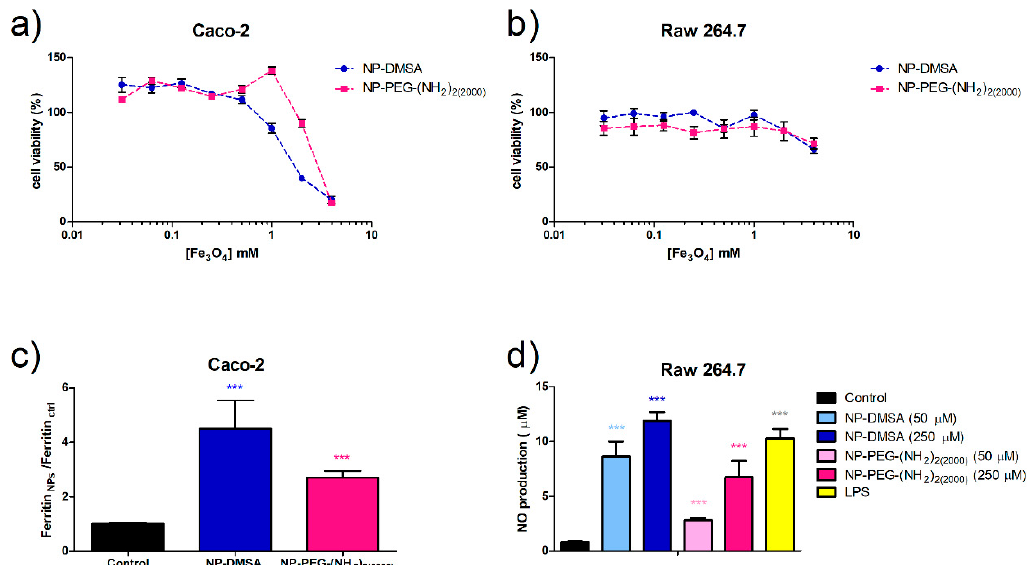
Figure 7. Evaluation of cell viability by MTT assay. ( a ) Caco-2 cells. ( b ) RAW 264.7 cells. ( c ) Ferritin formation measured by ELISA in Caco-2 cells exposed to 250 µM of NP-DMSA or NP-PEG-(NH 2 ) 2(2000) . ( d ) Evaluation of macrophages activation by measurement of nitric oxide production. Data represent means ± SD ( n = 3). * Shows statistical significance compared with the control (one-way ANOVA, Bonferroni´s post-hoc test * p < 0.05, ** p < 0.01, *** p < 0.001, **** p < 0.0001).